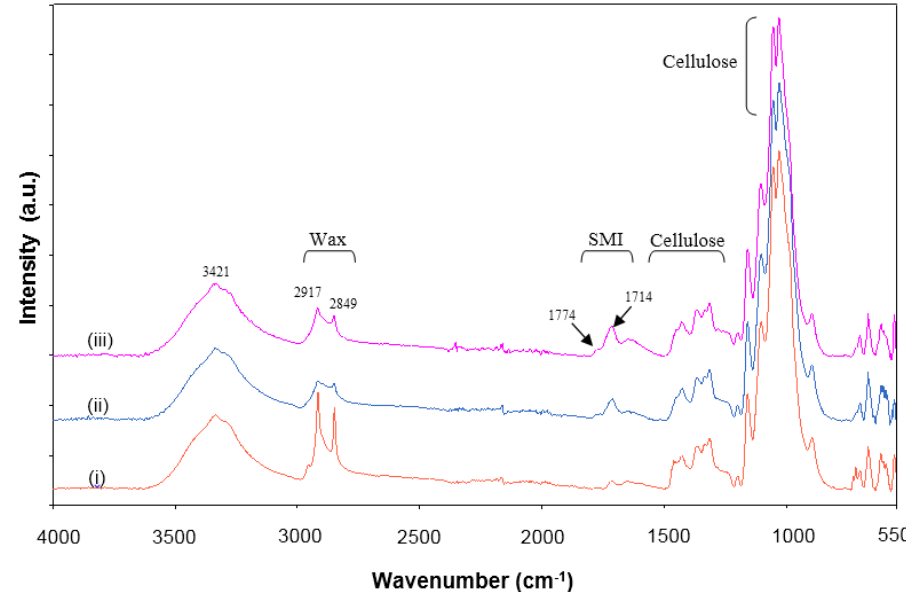
Figure 9. FTIR spectra for cured modified MFC films at 220 °C for different curing times of (i) 1 h; (ii) 2 h; and (iii)